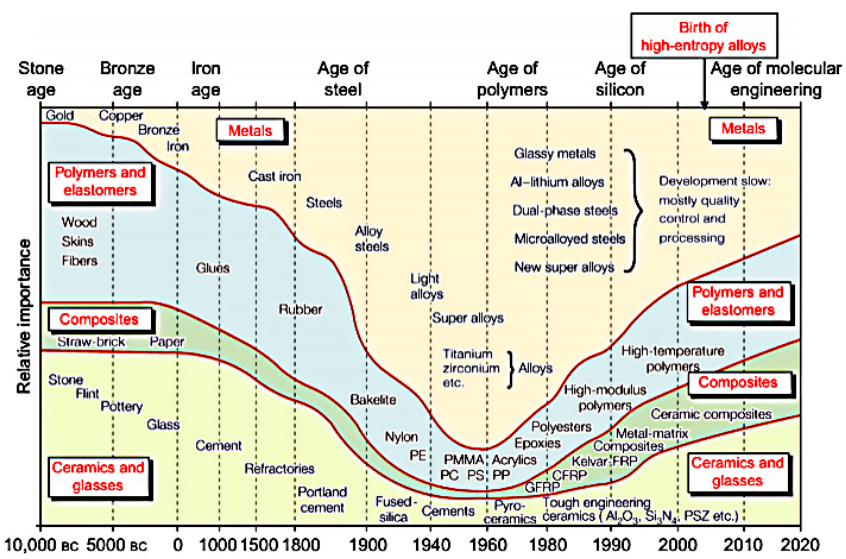
Figure 1. Historical evolution of engineering materials [11].